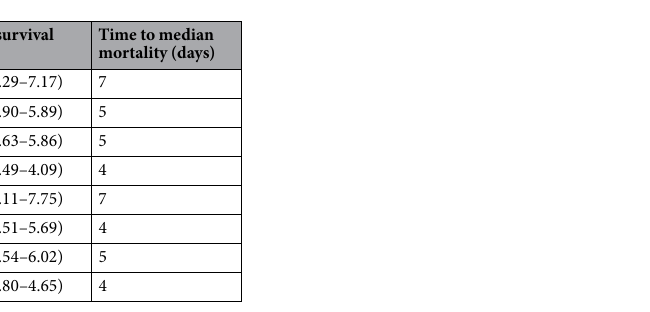
Table 3. Mean survival and time to median mortality of mosquitoes feeding on blood samples with matching concentrations ( + / − 1 ng/ml) of ivermectin with (K) or without ketoconazole at CYP inhibition